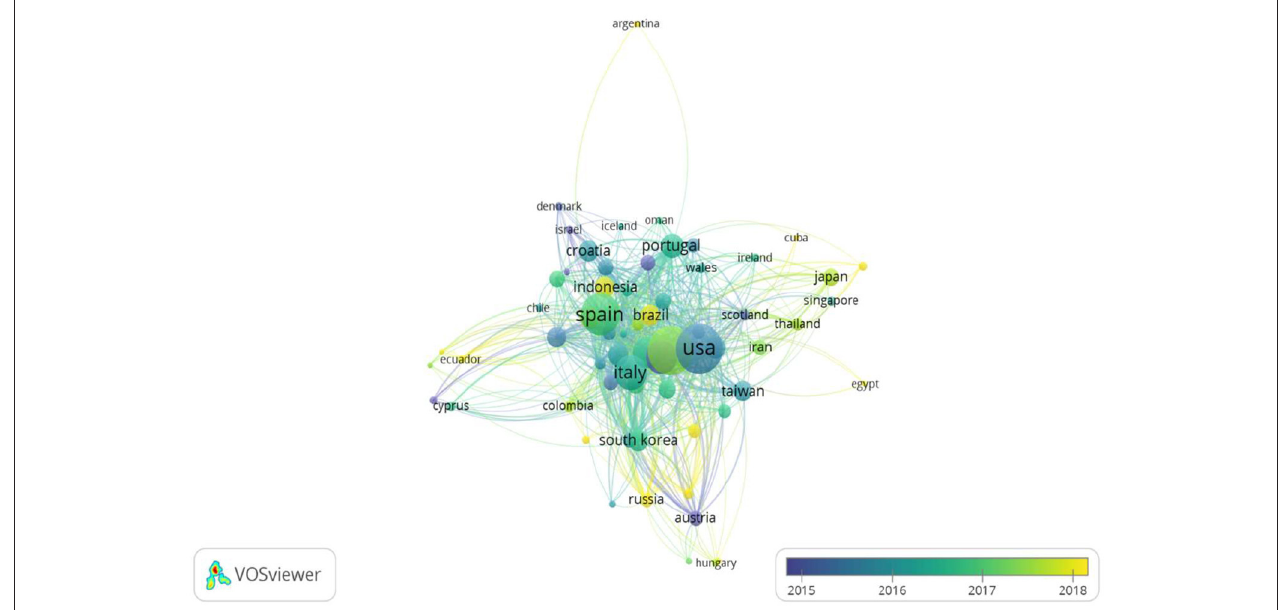
FIGURE 6 | Analysis of country citations by temporal distribution. Source: prepared by the authors using VOSviewer, based on WoS data.